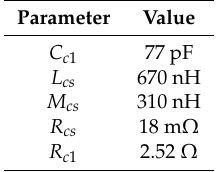
Table 2. Cable model parameters.